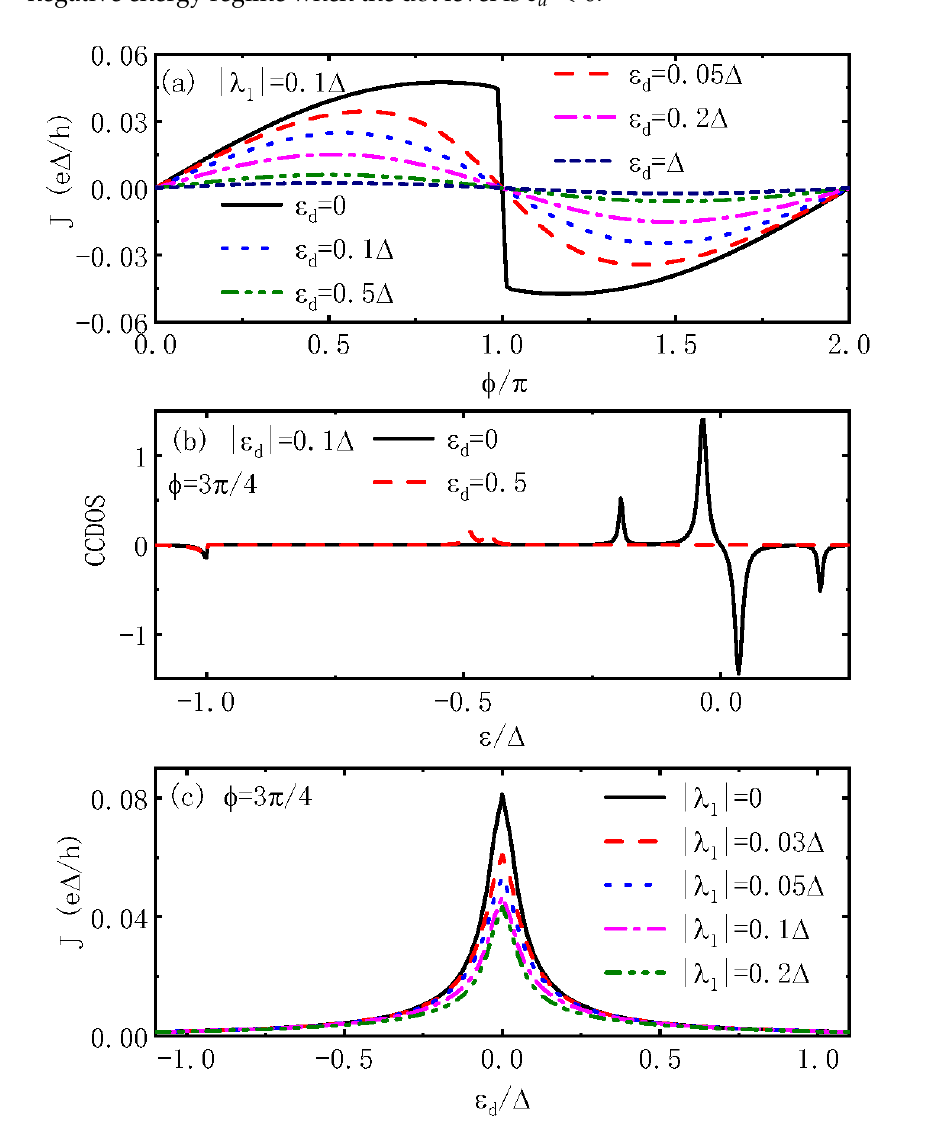
Figure 3. (Color online) Josephson current varying with respect to φ in ( a ) for different values of dot level ε d and the CCDOS versus electron energy in ( b ). ( c ) is for J as a function of φ for fixed φ = 3 π /4 and different | λ 1 | . Unless listed in the figures, the parameters are the same as in Figure